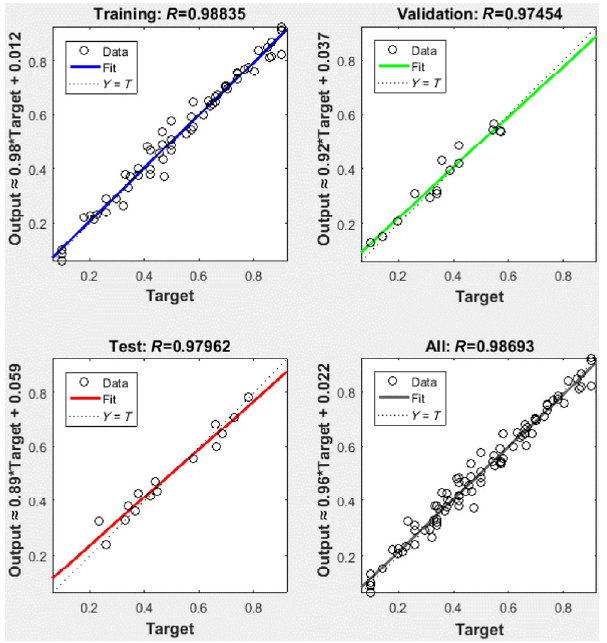
Fig. 20 Regression plot of optimized multi hidden layer ANN architecture (Network No.